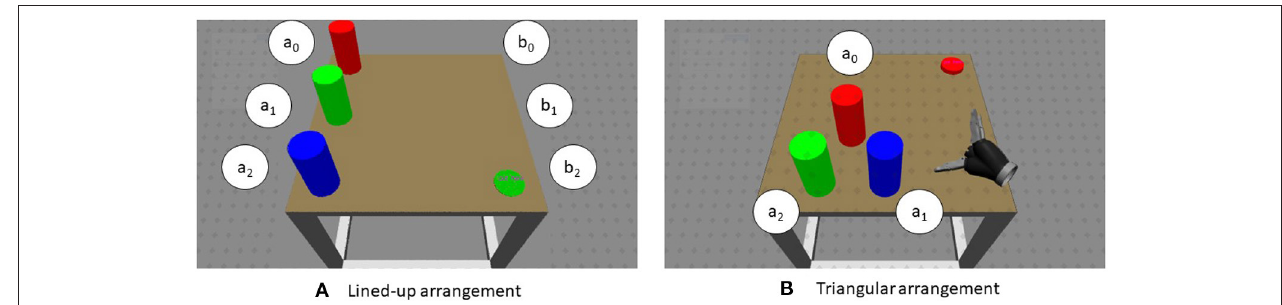
FIGURE 2 | Example of scenes used in each trial. The objects to pick up were displayed lined up on the left side (or in a triangular arrangement) in three different colors while the disc on the right could similarly appear at each of three positions on the right side. The color of the disk signified which cylinder was to pick up, the position of the disk denoted the position for the placing down. The white disks are just shown here to label the picking and placing positions. (A) Lined-up arrangement. (B) Triangular arrangement.